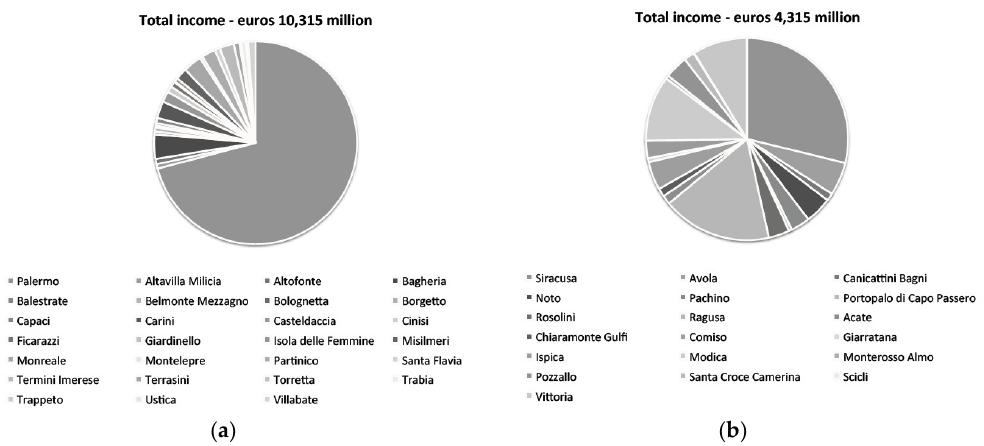
Figure 2. Gross annual income (2015) per municipality and per metropolitan area for ( a ) NWS and ( b ) SES (our elaboration on Italian National Statistical Institute (ISTAT) data).